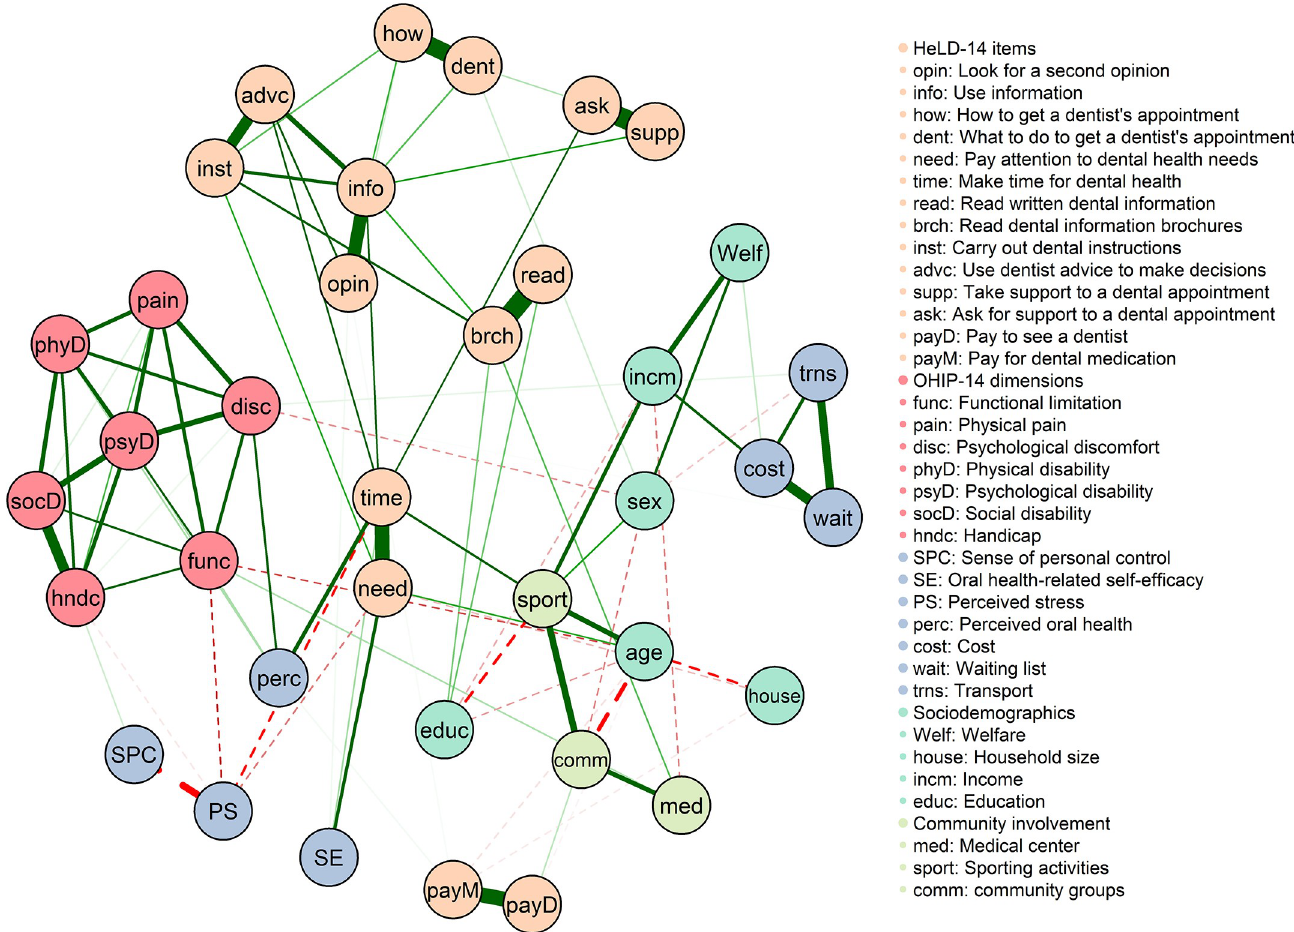
Fig 2. Estimated network for HeLD-14 items and